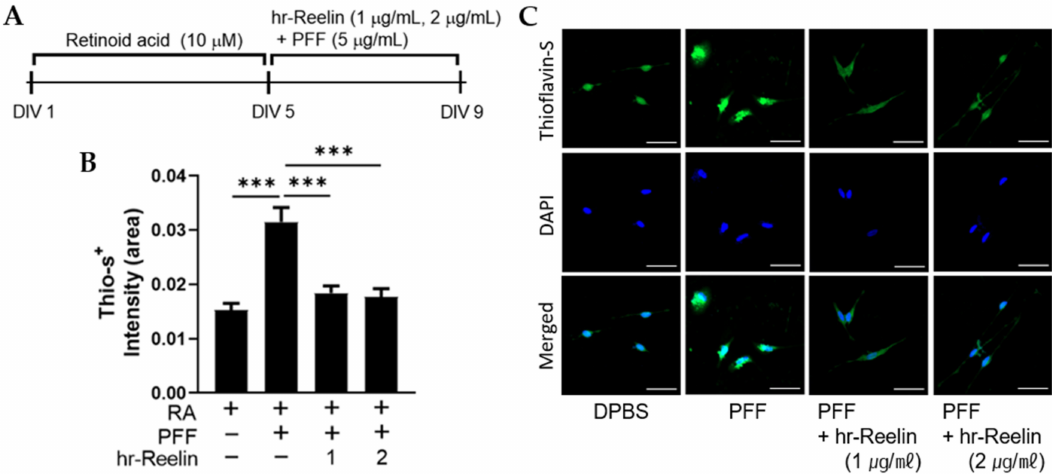
Figure 7. Aggregated α -Synuclein protein formation was measured by Thioflavin-S (Thio-S) staining in preformed fibril (PFF)-treated SH-SY5Y cells. ( A ) Differentiated SH-SY5Y cells were incubated with either PFF or human recombinant Reelin (hr-Reelin) protein (1 µ g/mL and 2 µ g/mL). ( B ) Each of Thio-S-positive intensities were compared between groups. ( C ) Representative images of ( B ). scale bars, 50 µ m. Mean ± S.E.M. n = 52–95 cells in each group. One-way ANOVA (Bonferroni post hoc test), *** p < 0.001. Retinoic acid; RA, days in vitro;